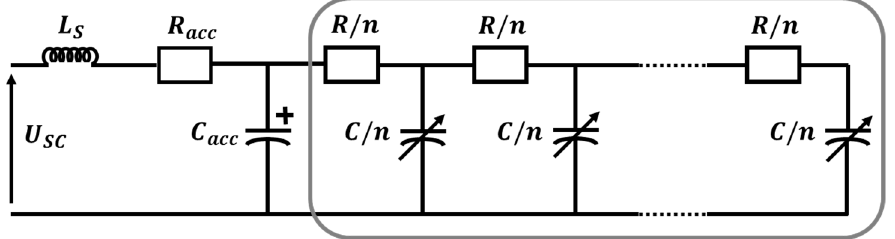
Figure 3. SC frequency domain model proposed by Lajnef et al (adapted from [21]).